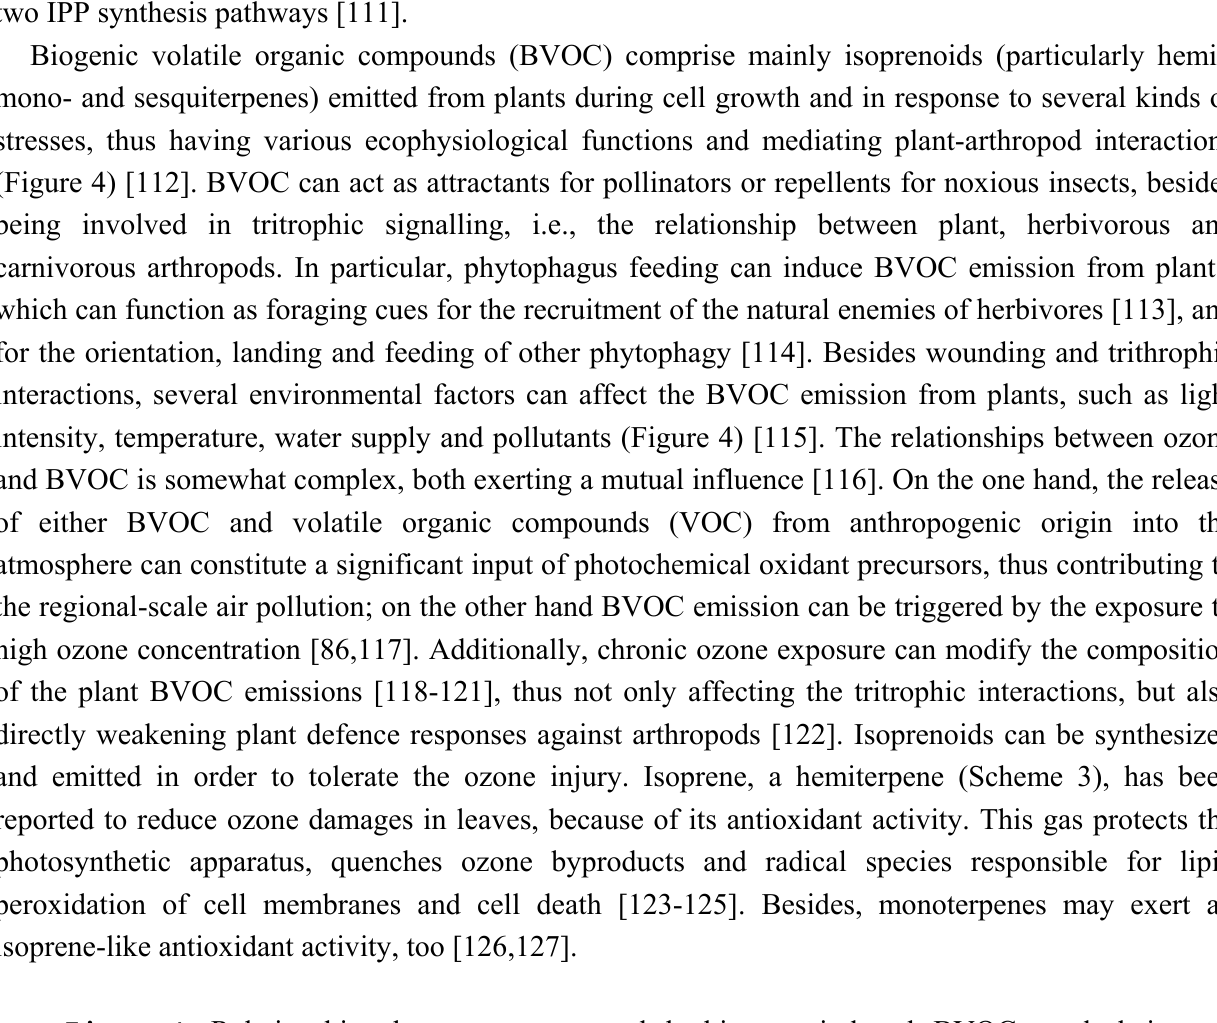
Figure 4. Relationships between ozone and herbivorous-induced BVOCs and their influence on photochemical ozone precursors and on tritrophic interactions,